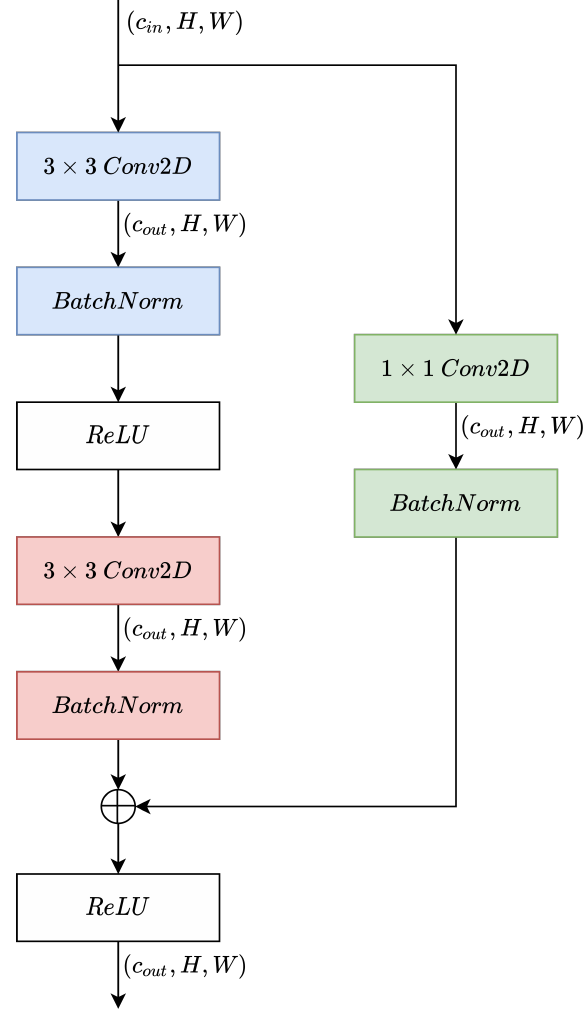
Figure 5. Residual blocks used to cause the autoencoder to